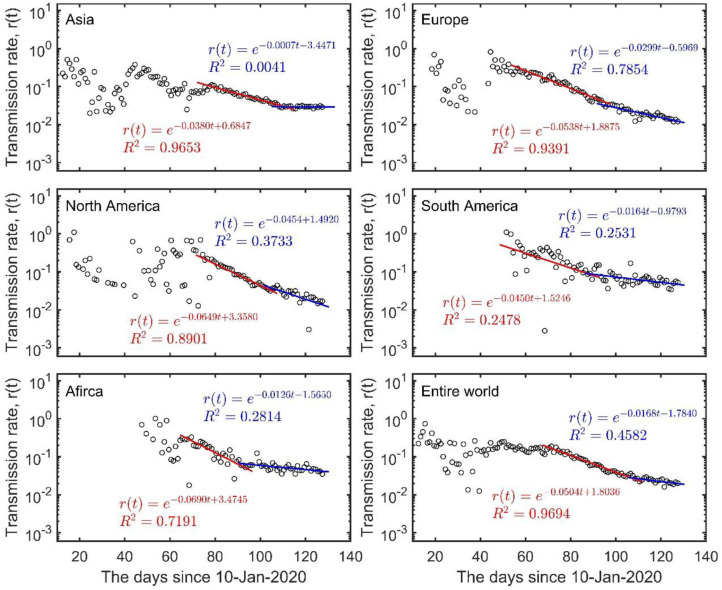
The two-stage damping of COVID-19 in Asia (excl. China), Europe, North America, South America, Africa, and the entire world. The red and blue lines represent the regressions of the data in first and second stage separated at 28 April in Asia, 12 April in Europe, 22 April in North America, 7 April in South America, 11 April in Africa and 26 April for the entire world. Circles indicate the data. See detail in Table 1.